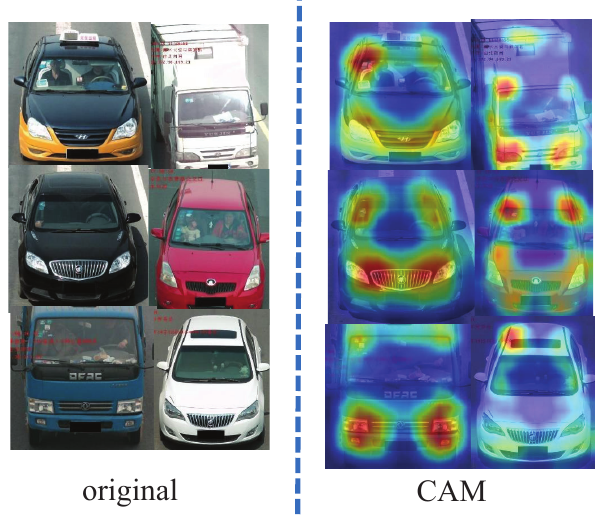
Figure 3. Images results from an original to Spatial Relation-Aware samples.